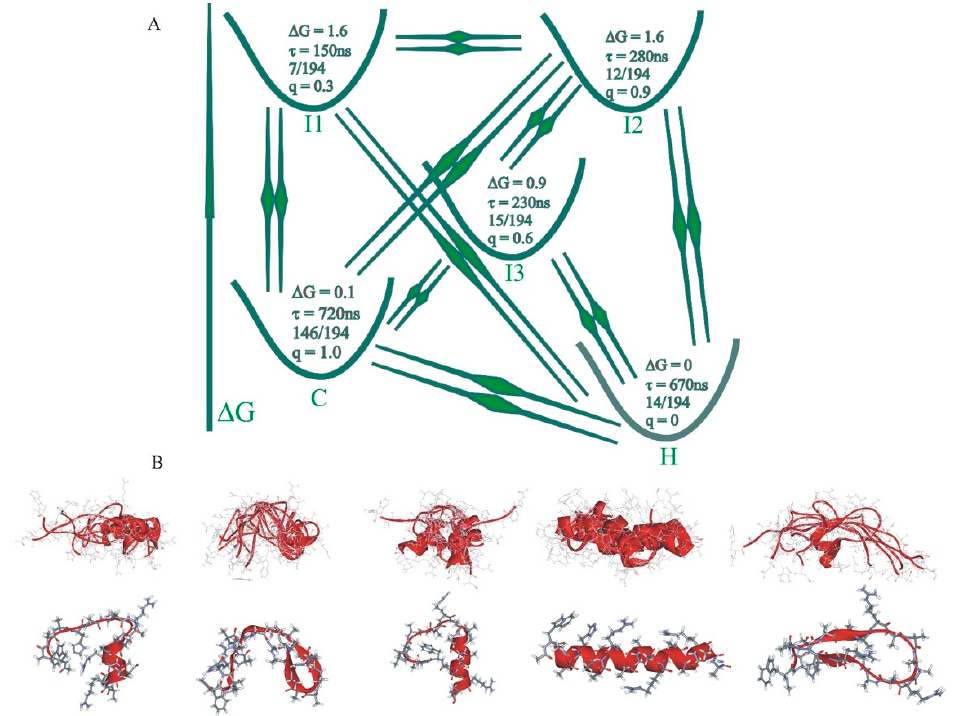
Figure 3. Kinetic network diagram. Analysis of the reduced dimensionality model for WH21 0 with N = 5 coarse-grained states. ( A ) The kinetic connectivity representing the R matrix. ( B ) The structures from the corresponding cluster center. In B, the top row represents a complete ensemble of cluster centers for each metastable state. The row at the bottom shows the central structure of the most highly populated cluster in each metastable state [79].